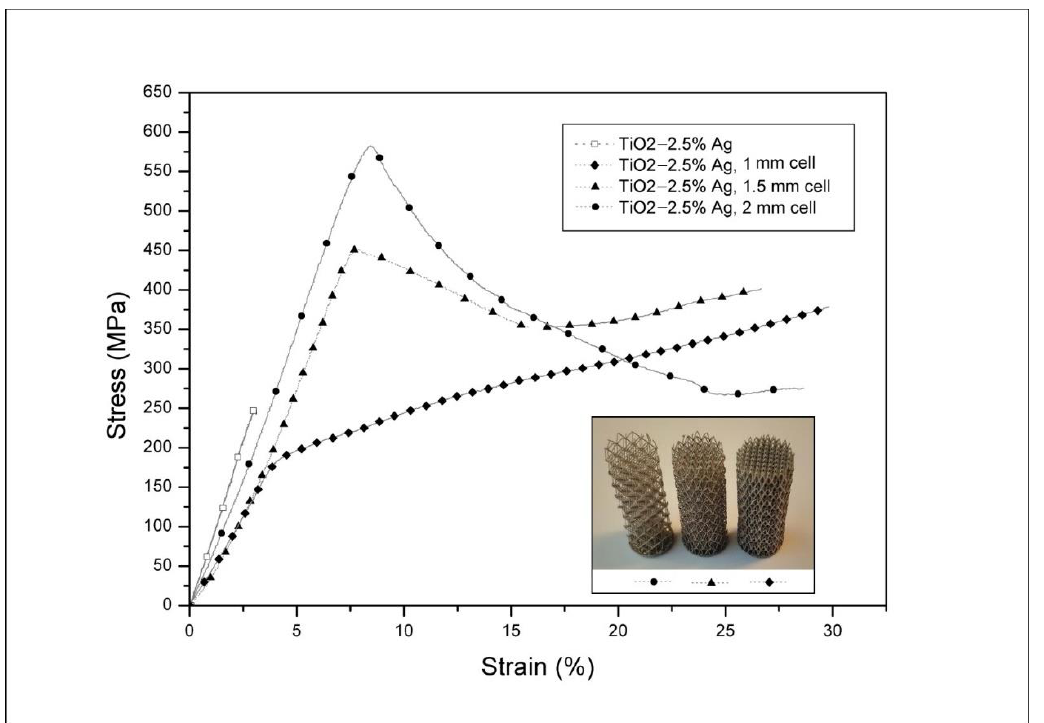
Figure 7. Compressive test results for TiO 2 –Ag without and with different unit cell sizes of lattice structure. Height of lattices were 25 mm and diameter was 10 mm before SPS.